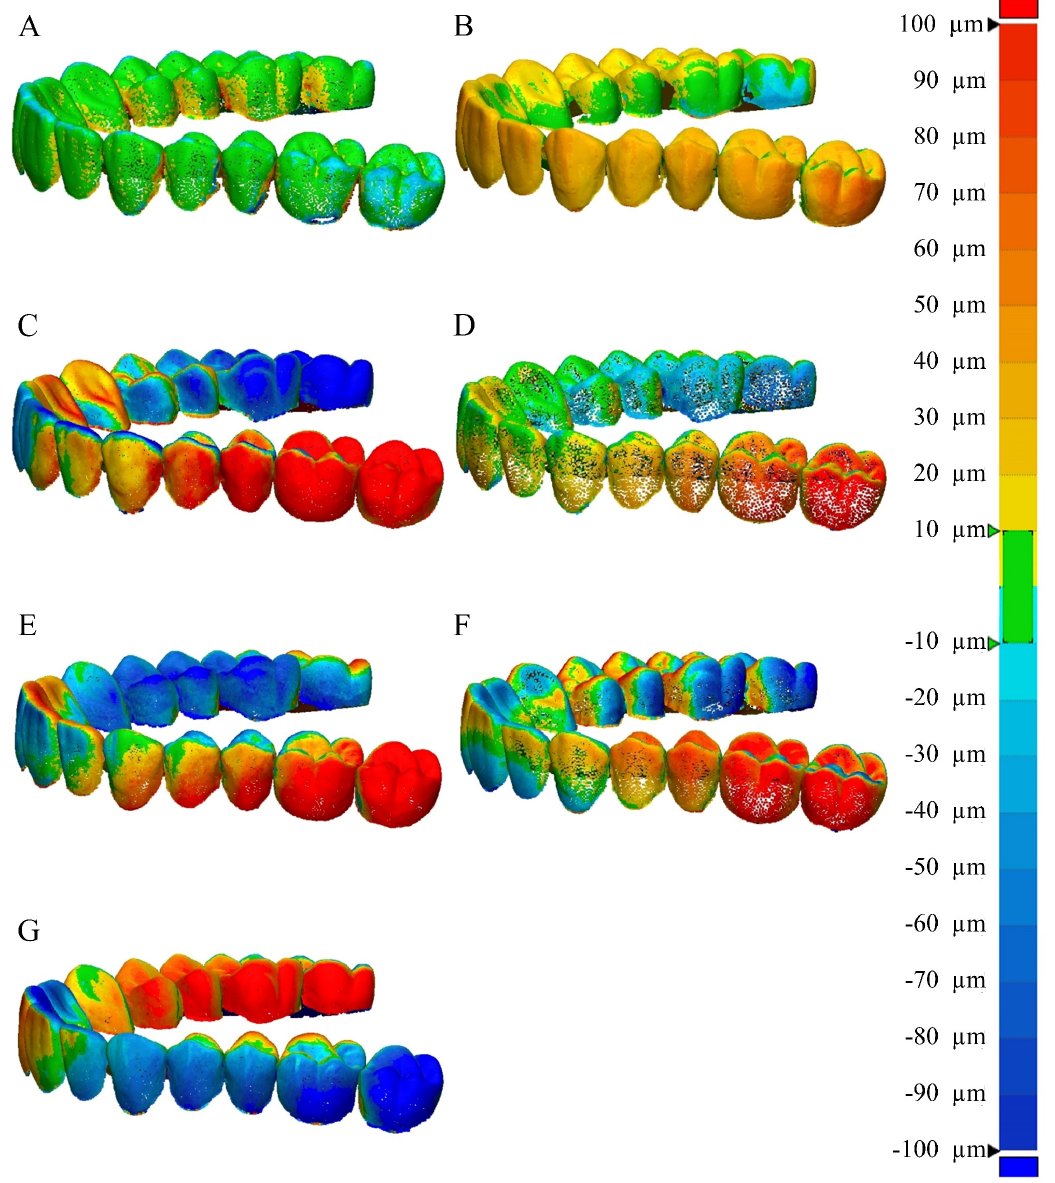
Figure 6. Comparison of the color map of 3D displacement according to the 3D scanners. ( A ) 3Shape E1, ( B ) DOF, ( C ) CS3500, ( D ) CS3600, ( E ) Trios2, ( F ) Trios3, and ( G )